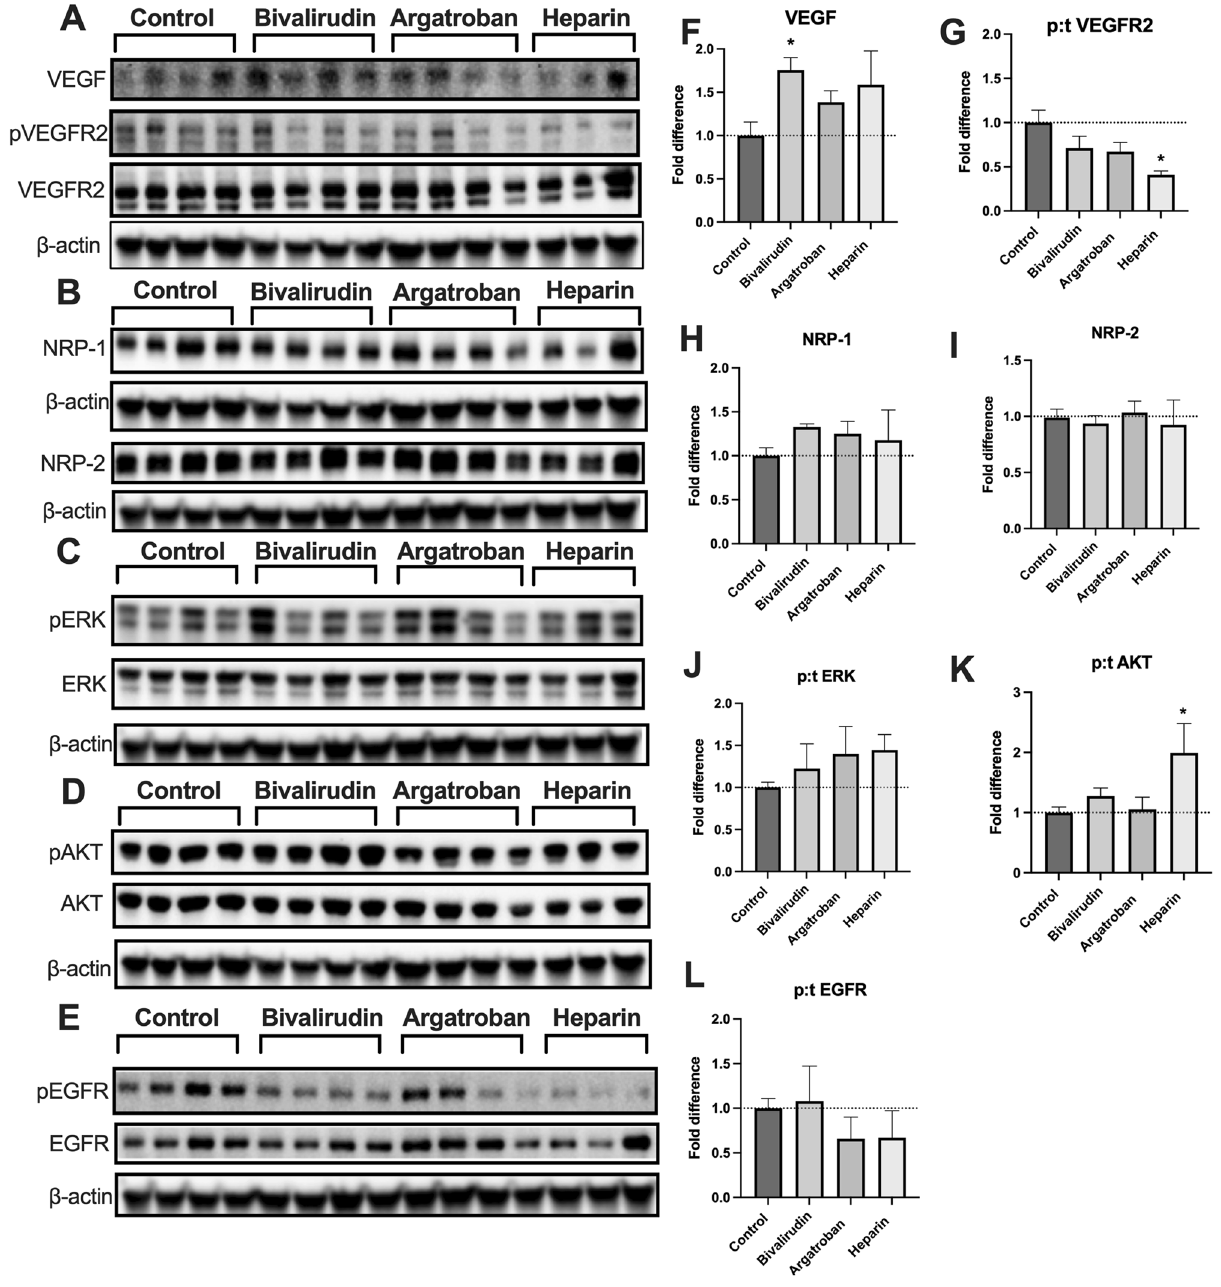
Figure 6. Lung tissue immunoblots. Pulmonary VEGF expression was higher in the bivalirudin group compared to controls ( A,F ) while there were no significant differences in the heparin and argatroban groups. Activation of VEGFR2 (phosphorylated/total receptor VEGFR2) was significantly lower in heparin-treated mice ( G ). There were no significant differences in the expression of the co-receptors neuropilin-1 (NRP- 1) or neuropilin-2 (NRP-2) in then bivalirudin, argatroban, or heparin groups ( B,H,I ). Activation of the downstream proliferation marker ERK (phosphorylated/total receptor ERK) was not significantly different in the anticoagulated groups ( C,J ). Heparin-treated mice demonstrated increased activation of the downstream mediator Akt (phosphorylated/total Akt; D,K ). Activation of an alternative pathway involving the epithelial growth factor receptor (phosphorylated/total EGFR) was lower in the argatroban and heparin groups, although not reaching statistical significance ( E,L ). Uncropped blots are provided in Supplementary Information Files 1,2. The β-actin for each membrane is displayed below the corresponding antibodies and was used to normalize the expression patterns. Each lane represents a sample from a different mouse. Statistical analysis of protein expression was done using analysis of variance (ANOVA), with Dunnett’s adjustment for multiple comparisons. Results are expressed as mean ± standard error. * P <